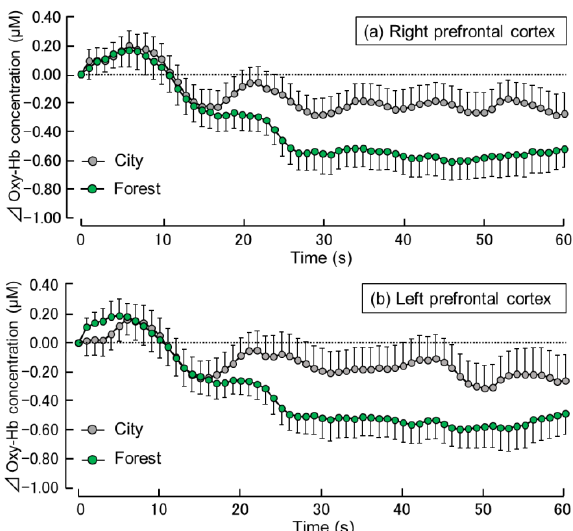
Figure 3. Time-dependent changes in the oxy-hemoglobin (oxy-Hb) concentrations in the right ( a ) and left ( b ) prefrontal cortex during 60 s exposure to the forest vs. city sounds. Data are expressed as mean ± standard error (n = 29).